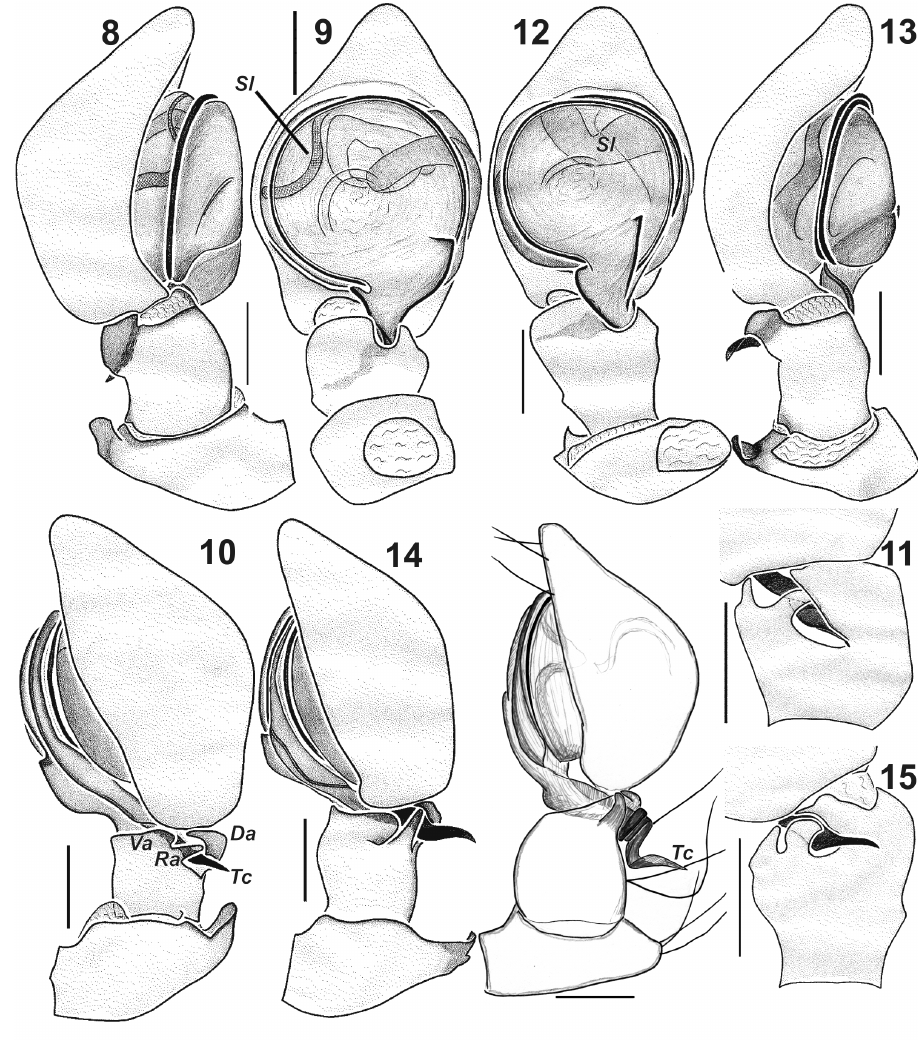
conductor and base of cymbium, dorso-retrolateral. Abbreviations: Da dorsal apophysis; Ra retrolateral apophysis; Sl loop of seminal duct; Tc posterior tip of conductor; Va ventral apophysis.